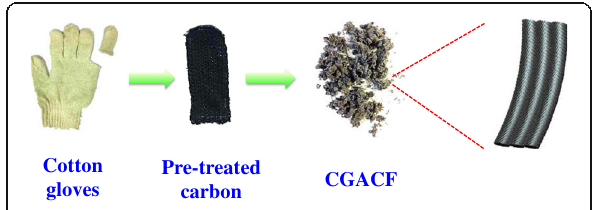
Fig. 1 Schematic diagram for the preparation of CGACF